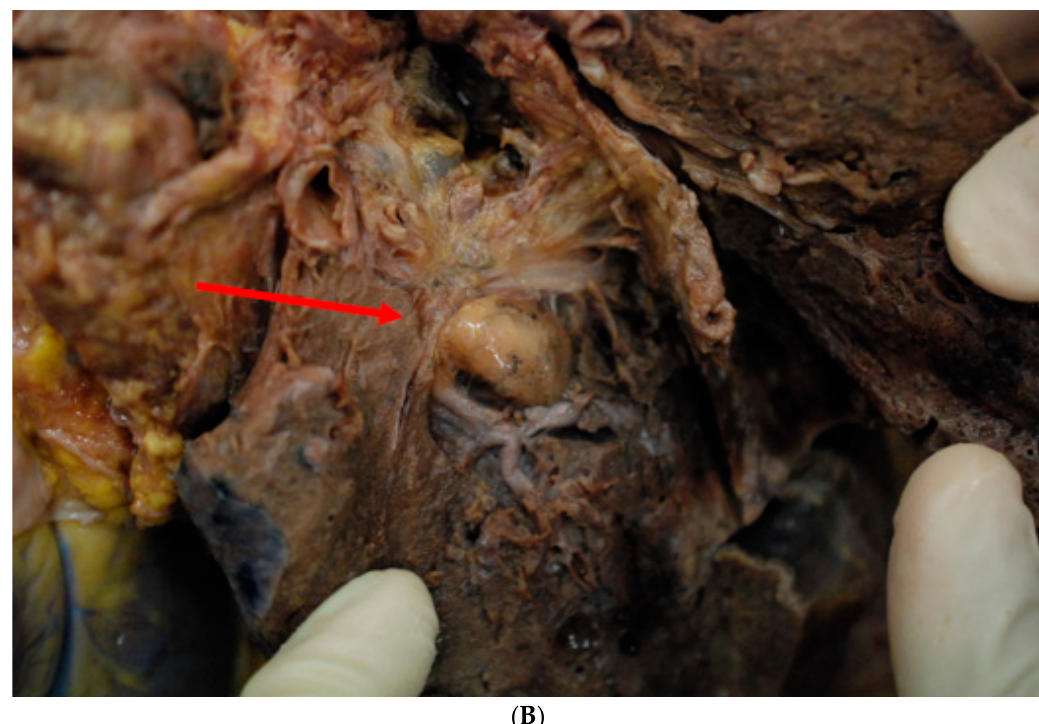
Figure 3. ( A ) The external surface between the superior and medial right bronchus, a mass, not protruding into the lumen, but with a rich vascularization that was partially fused to the bronchial wall, which appeared thinned and delaminated (red circle). ( B ) The arteriovenous malformation of the hamartomatous type after fixation of the sample in 10% neutral buffered formaldehyde (red arrow).